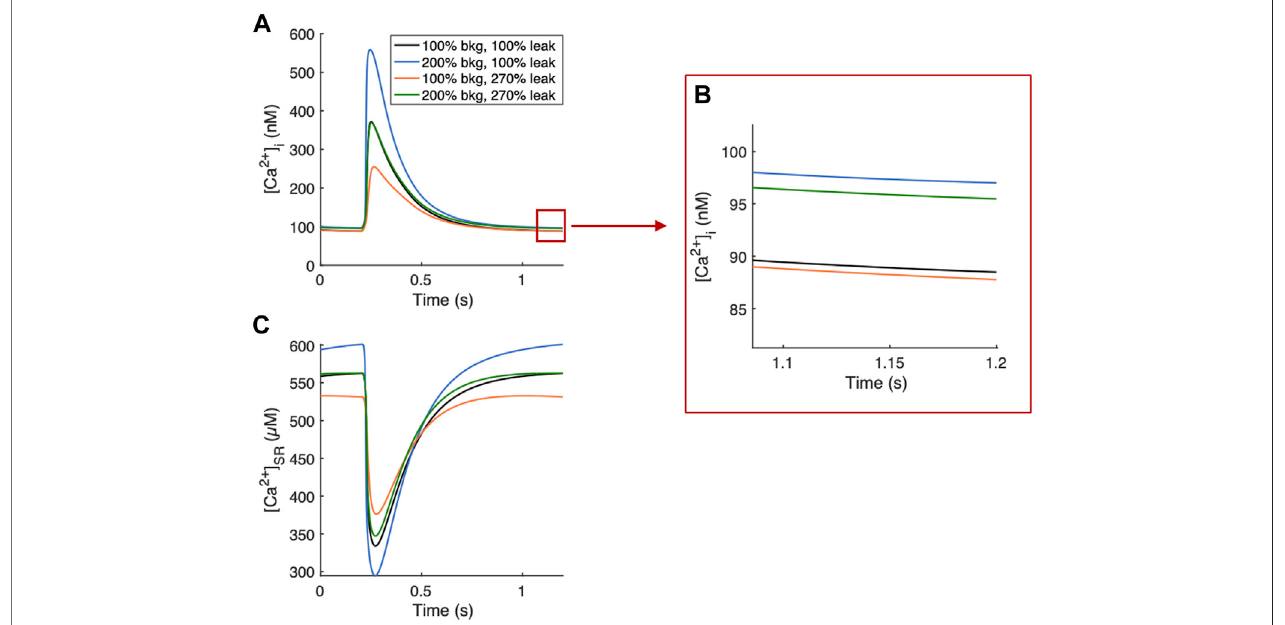
FIGURE8| ExampleCa 2+ transientsofbalancedbackgroundCa 2+ entryandSRCa 2+ leak. (A) 200%G bkg and270%K leak balancetheiropposingmodulationson systolic[Ca 2+ ] i whileincreasingdiastolic[Ca 2+ ] i by7.9%. (B) Zoomed-inregiondemonstrating7.9%increaseindiastolic[Ca 2+ ] i fromdefaultvalues(blackline). (C) 200% G bkg and 270% K leak balance opposing effects on SR